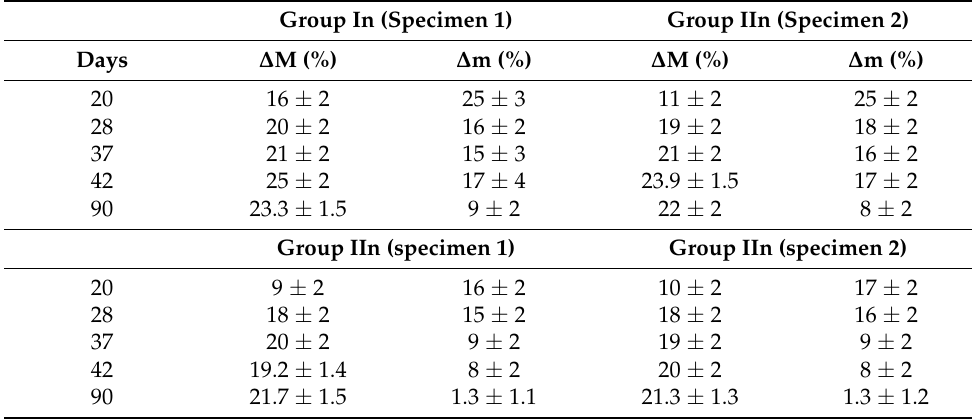
Figure 14. The ultrasonic speeds in the different types of mortars with natural carbonation Group In ( A ), Group IIn ( B ) where each value of V (Vx, Vy, Vz) corresponds to the mean value of the measurements taken in each direction of space. Mean Vm of the velocities is represented ( C ). Regarding the anisotropies, both total ( ∆ M) and relative ( ∆ m) have not provided conclusive results (Table 8), i.e., a clear trend is not observed, due to the shortage of study times. Table 8. Total anisotropy ( ∆ M) and relative anisotropy ( ∆ m) values of groups In and IIn mortar specimens for different time intervals elapsed since their